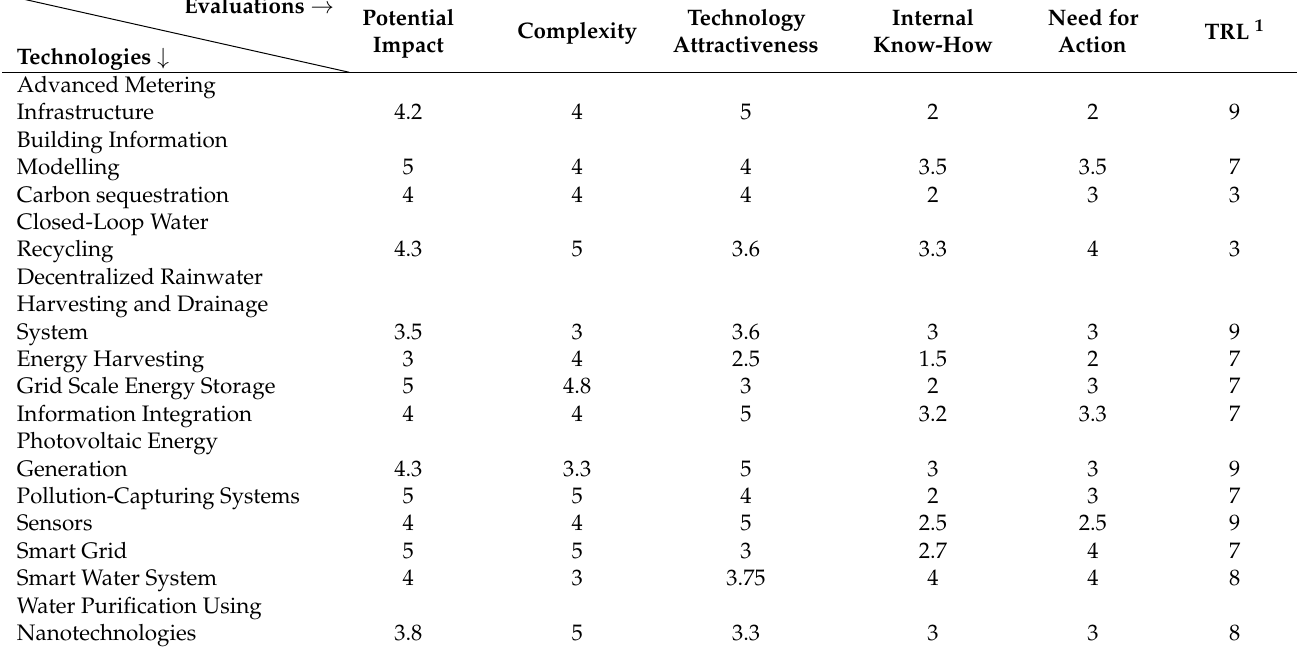
Table 9. Need for action